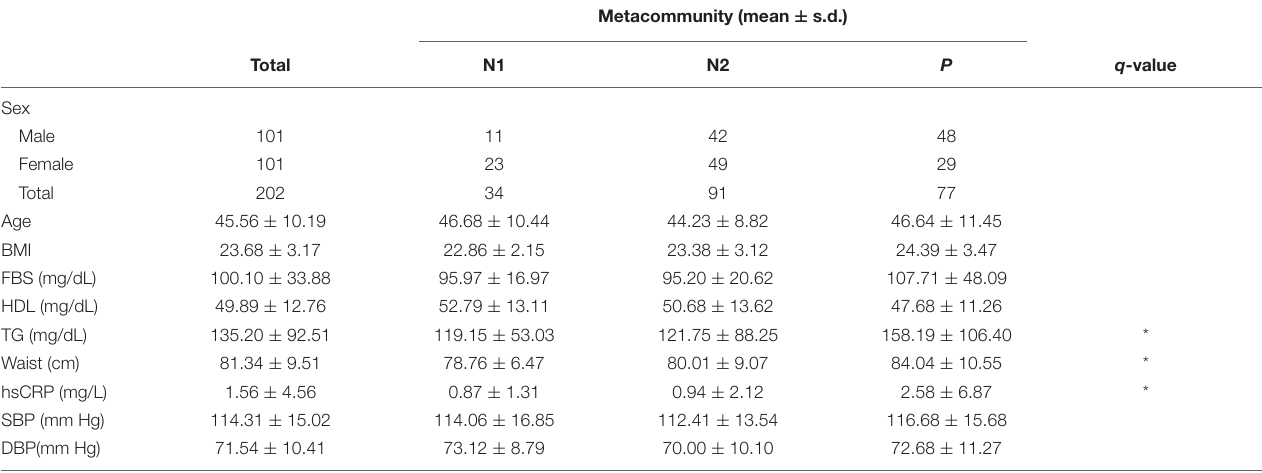
TABLE 1 | Demographic and clinical metadata in a